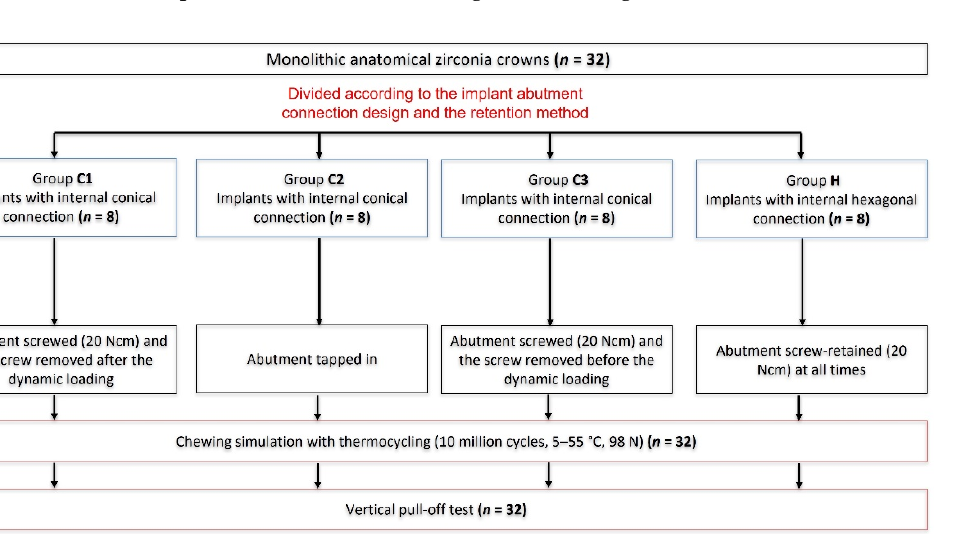
Figure 1. Setup of the study (H: internal hexagonal connection; C: internal conical connection).